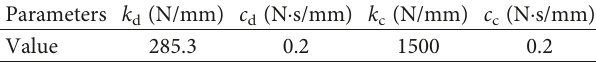
Table 3: The parameters of the spring-damping contacts used in the coupled FE model.